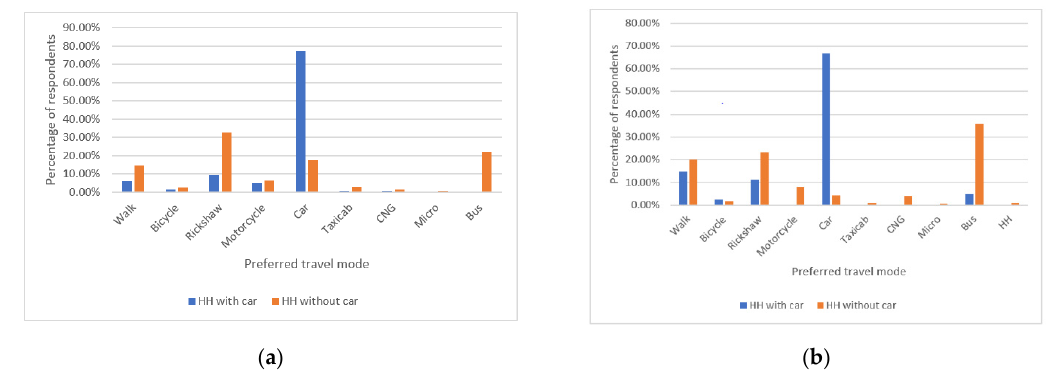
Figure 2. Change in people’s perception (preference) with car ownership status change in ( a ) Figure2. Changeinpeople’sperception(preference)withcarownershipstatuschangein( a )Dhanmondi Dhanmondi and ( b ) Mirpur area. and ( b ) Mirpur